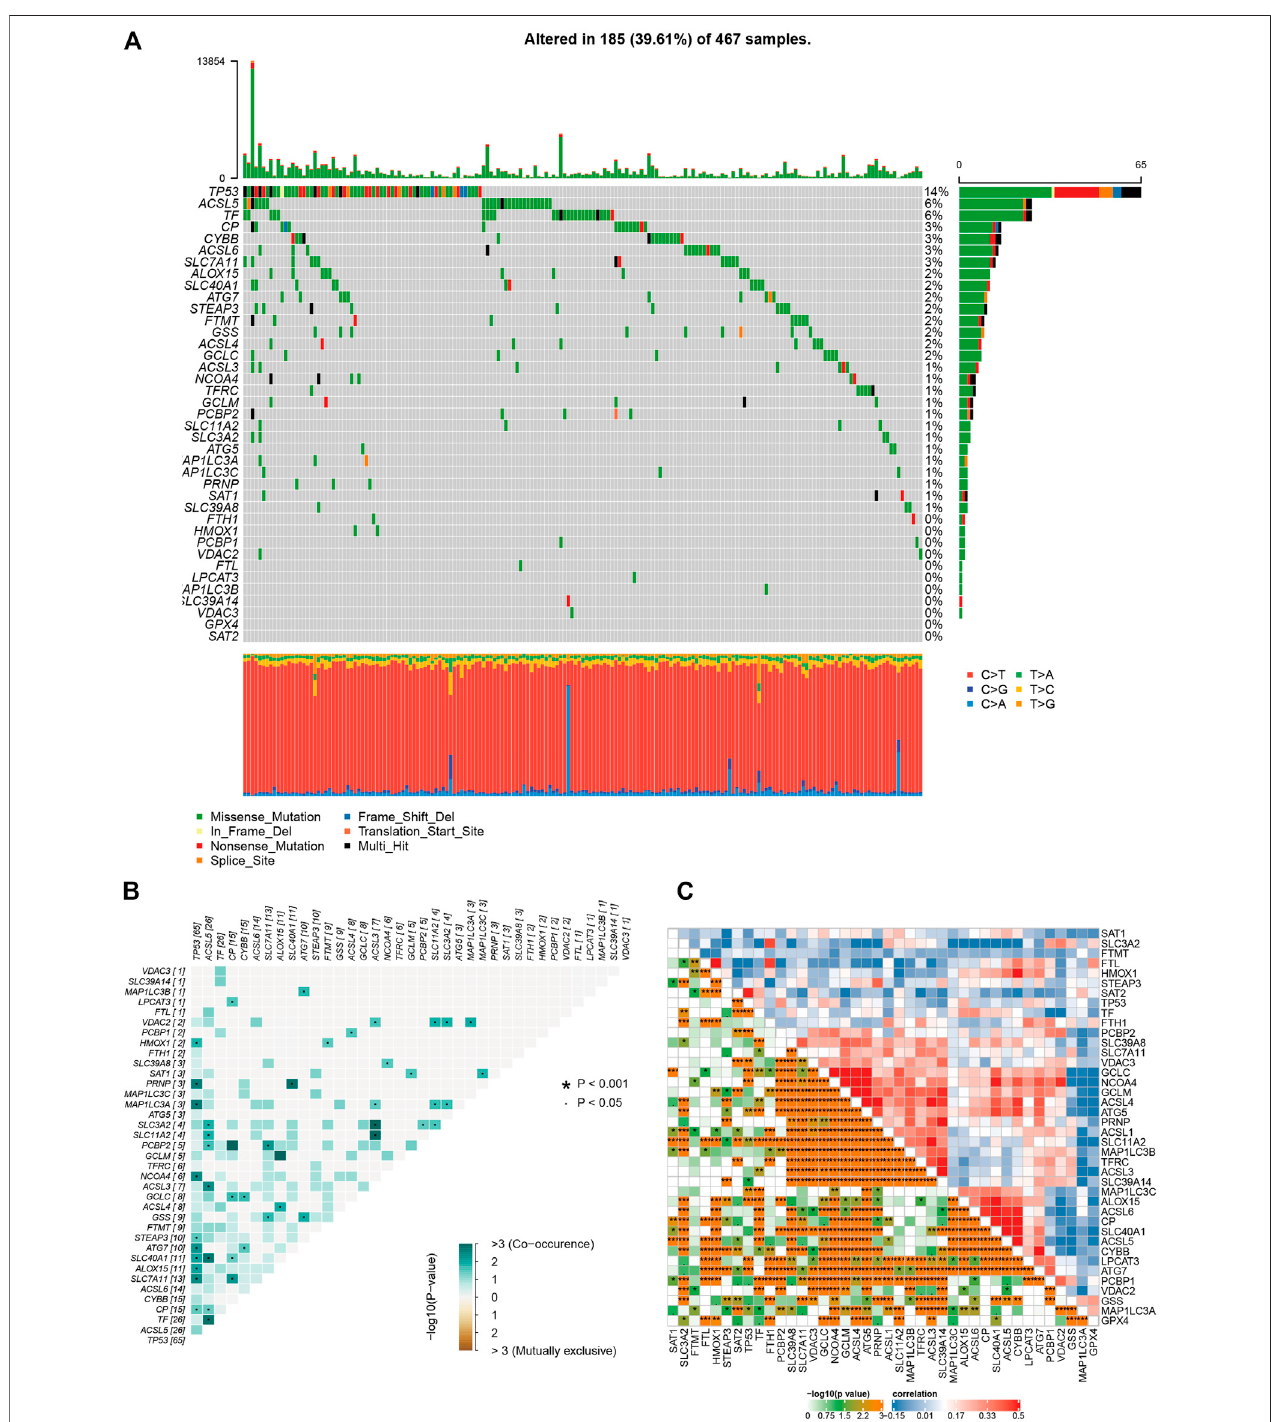
FIGURE1| Theresultsofmutationandcorrelationanalysis. (A) Thewaterfallplotshowedthehighfrequencyofmutationsof40ferroptosis-relatedgenesinSKCM as different colors representing different types of mutations. (B) The relationships of 40 mutation ferroptosis-related genes showed co-occurrence. (C) The correlations of gene expression of 40 ferroptosis-related genes.